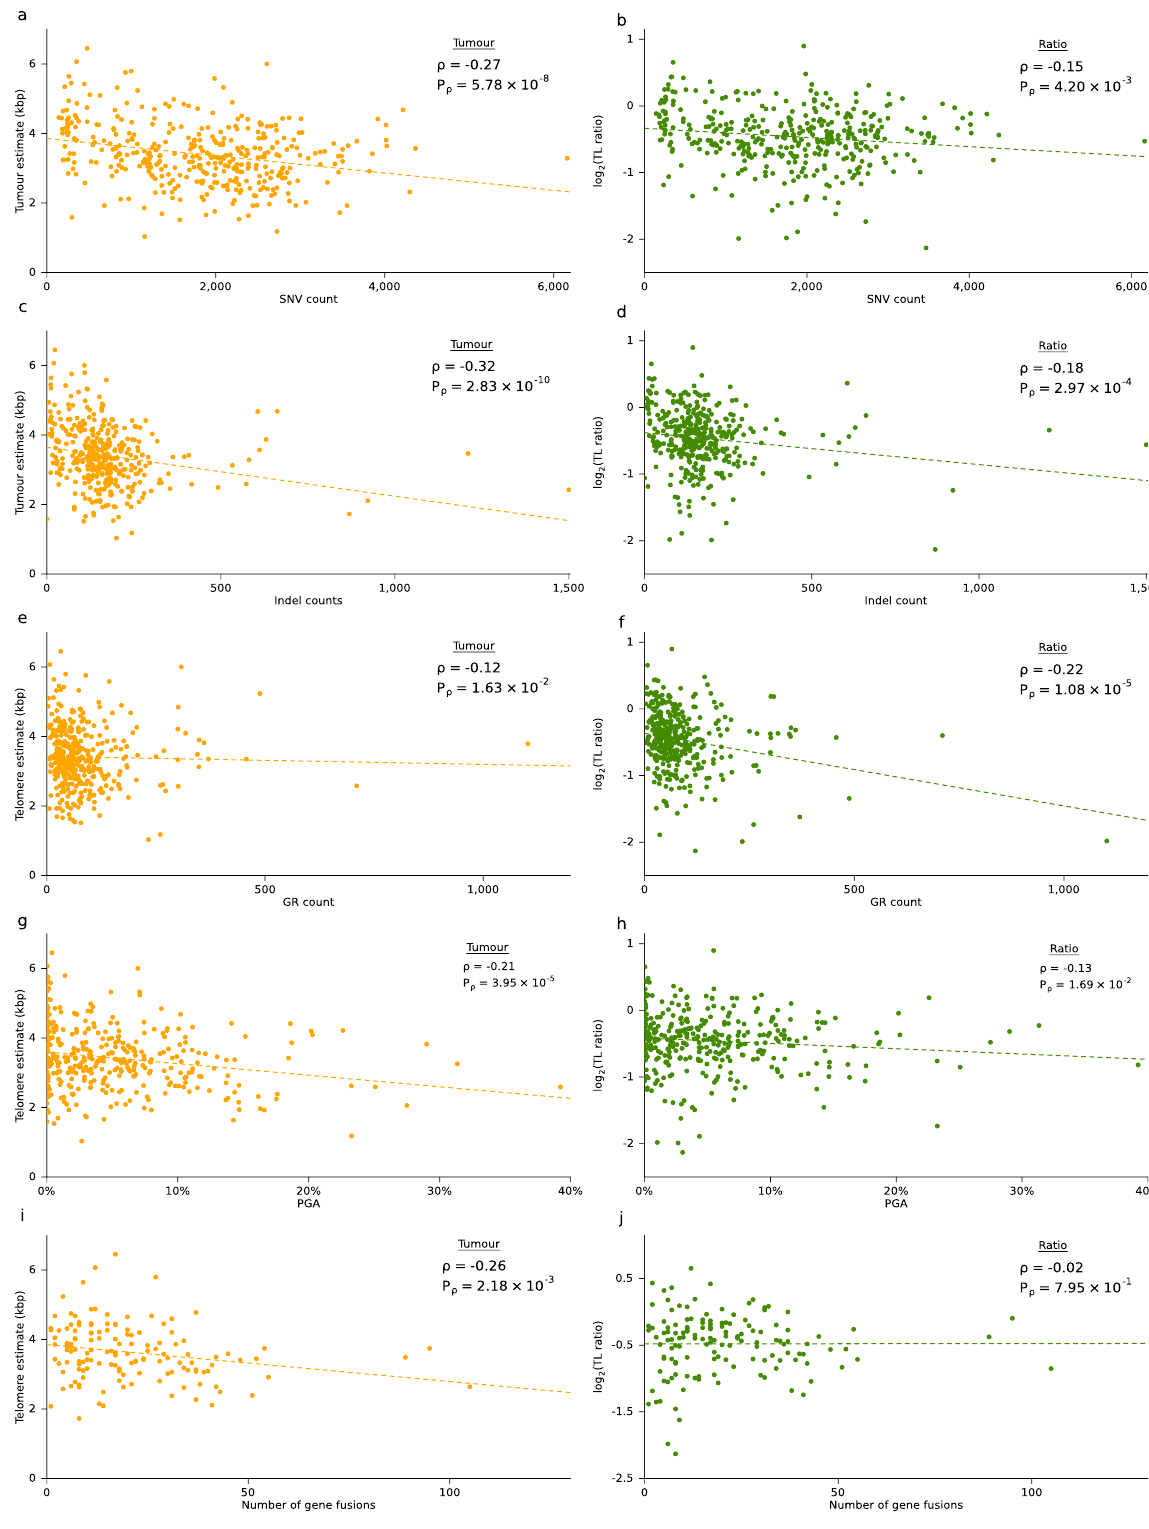
Fig. 2 Mutational landscape differs with telomere length. a , b Correlation between the number of single-nucleotide variants (SNVs) and a tumour telomere length (TL) b TL ratio. c , d Correlation between the number of indels and c tumour TL d TL ratio. e , f Correlation between the number of genomic rearrangements (GRs) and e tumour TL f TL ratio. g , h Correlation of percentage of the genome altered (PGA) and g tumour TL h TL ratio. i , j Correlation between the number of gene fusions and I tumour TL j TL ratio. Spearman ’ s ρ and P -values are displayed,